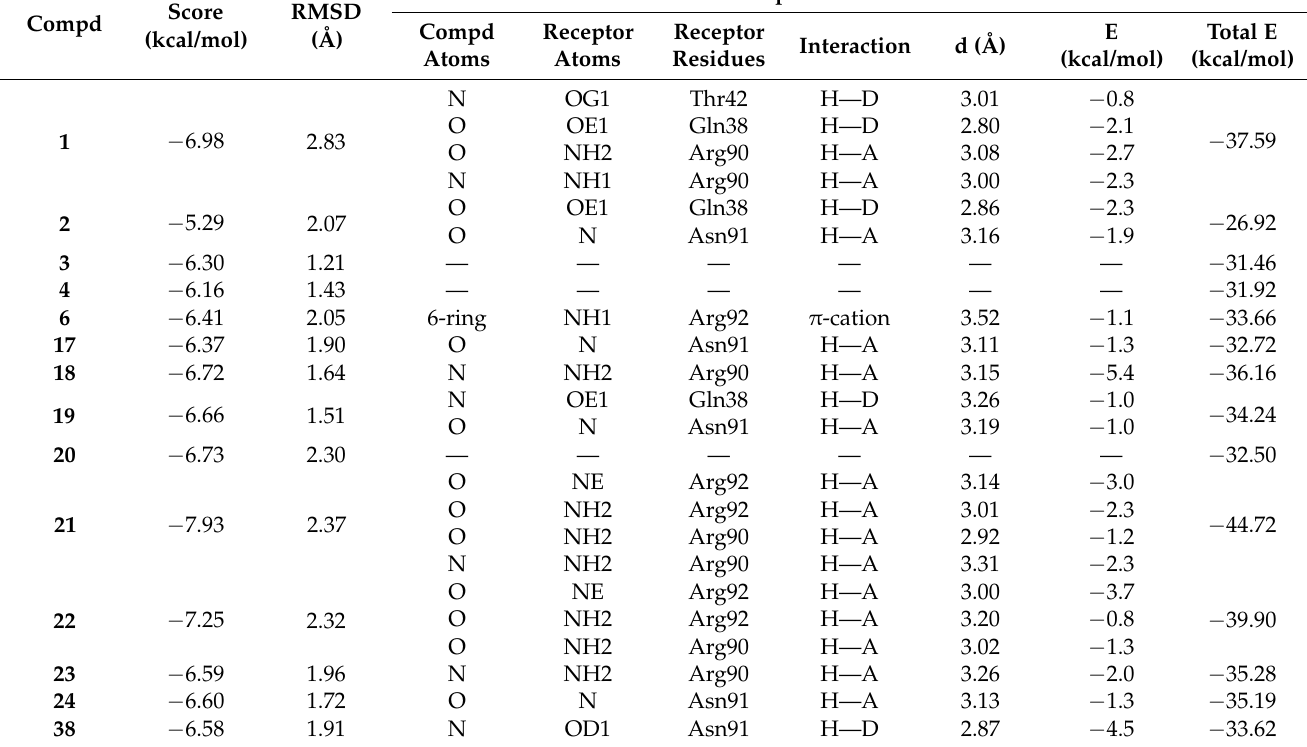
Table 5. Molecular docking score, RMSD, and binding affinity for the compounds showed valid molecular docking scores with